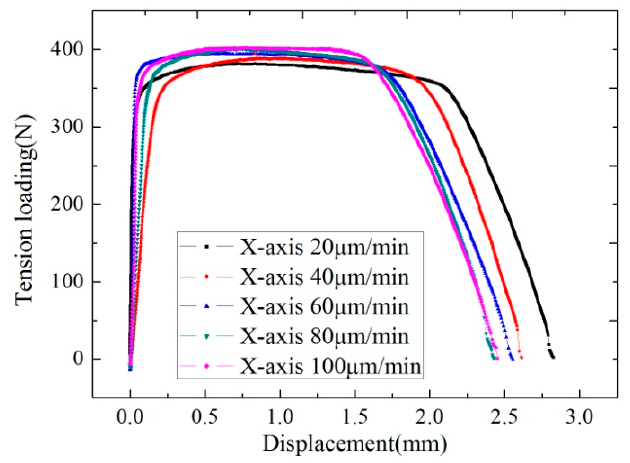
Table 4. The parameters of biaxial tension under different speeds.